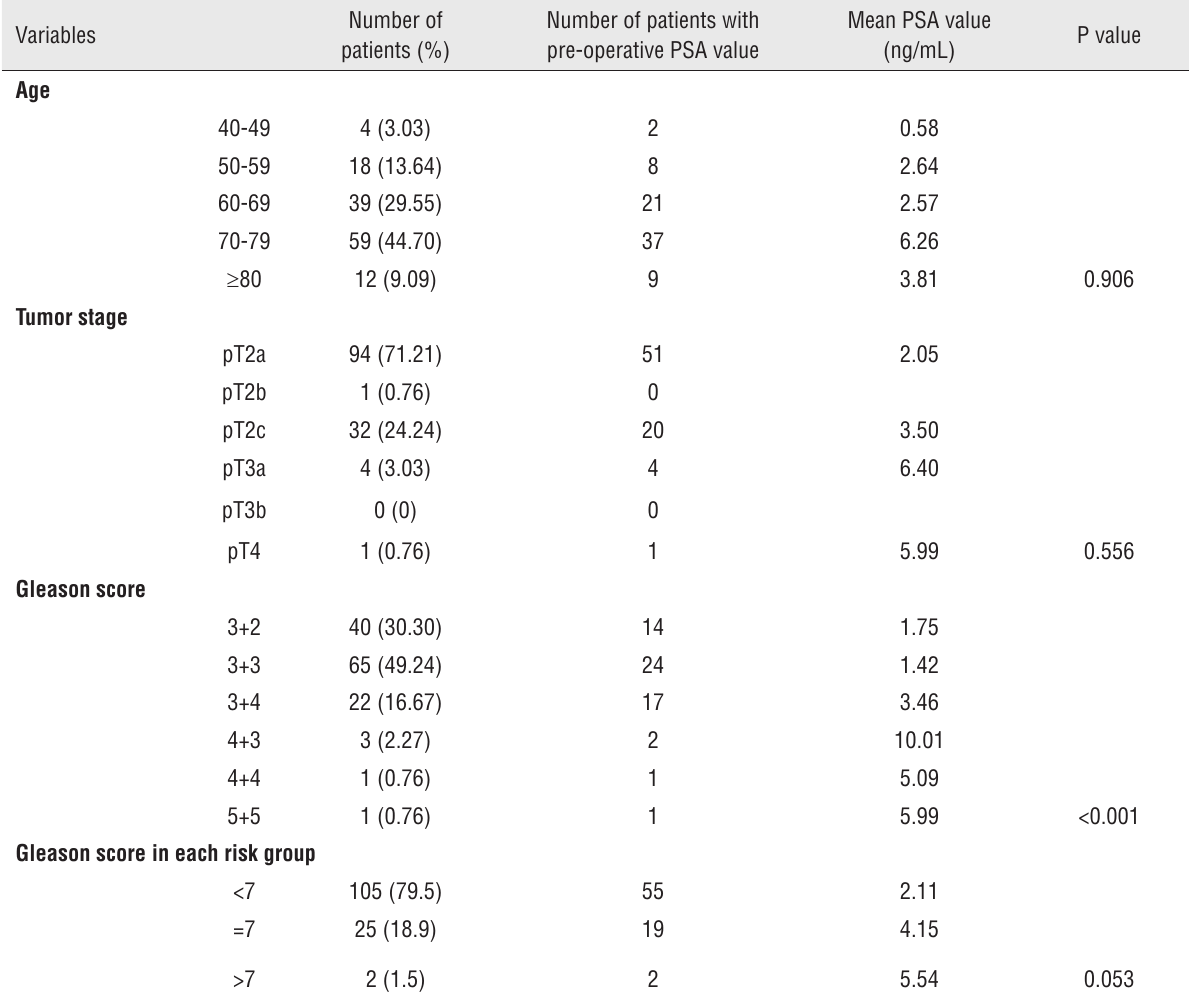
Number of Number of patients with patients (%) pre-operative PSA value